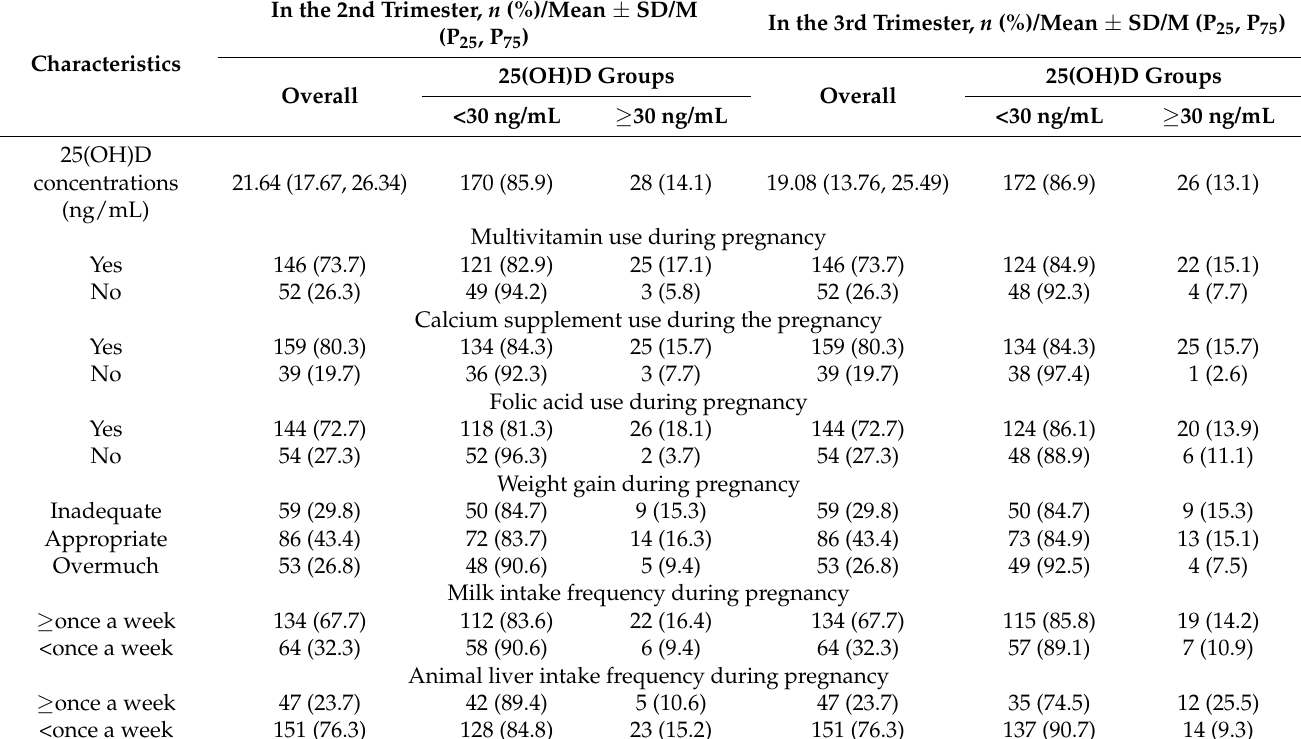
Table 3. The associations of serum vitamin D levels during pregnancy and pregnancy outcomes ( n =